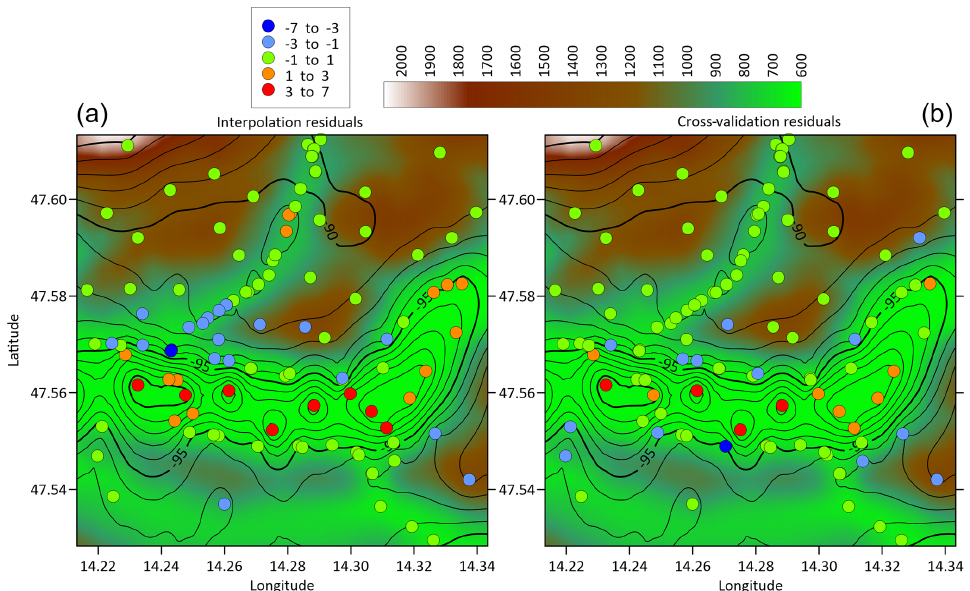
Figure 15. Interpolation and cross-validation residuals of a subset within a small section of the Enns valley in Austria. Background image is the topography: contour lines: CBA anomaly (mGal) interpolated using a high-resolution grid (about 200m spacing); colored dots: residuals ( a : interpolation; b : cross validation) at the scattered data points with respect to the AlpArray CBA grid (2000m spacing). Residuals in milligals (mGal); height in meters.